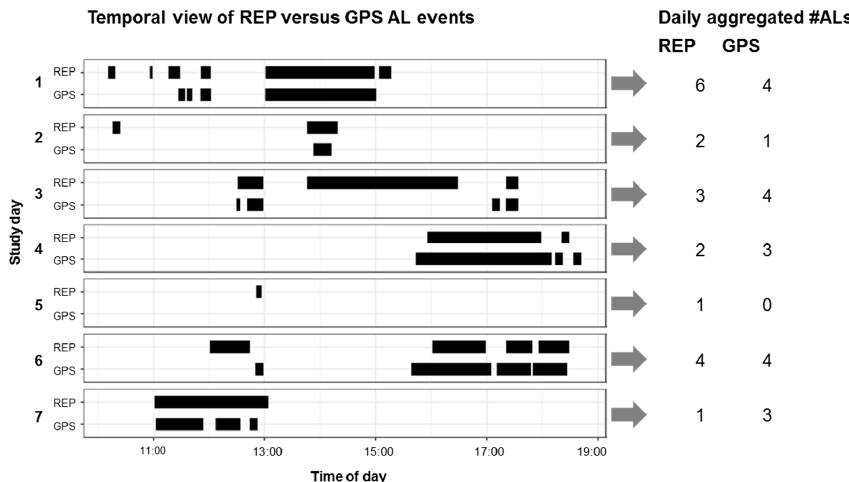
Figure 5 : Daily temporal view of REP versus GPS activity locations (left) and daily aggregated indicator REP #ALs and GPS #ALs (right) for one participant (one week).